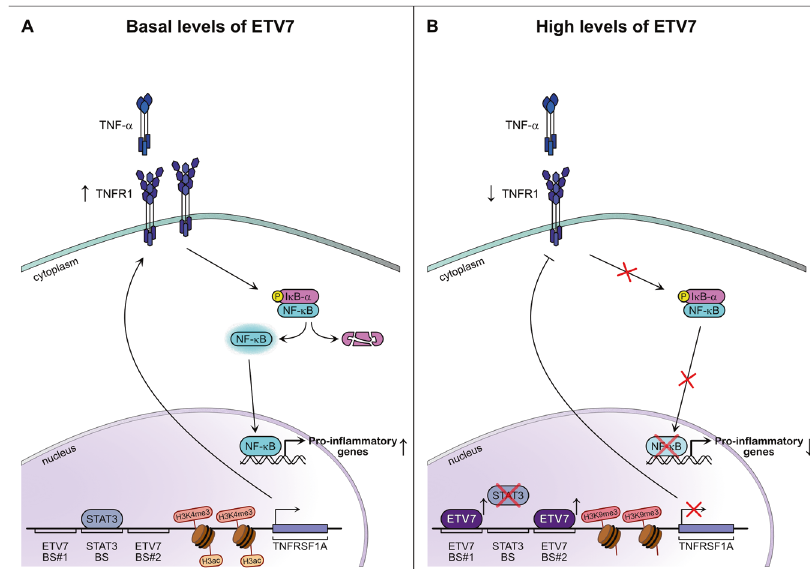
Fig. 7 ETV7 can compete with STAT3 in the regulation of the TNFRSF1A gene in fl uencing the NF- κ B regulatory pathway. A The canonical STAT3/TNF- α /NF- κ B regulatory pathway. STAT3 binds to its regulatory element in the fi rst intron of the TNFRSF1A gene and induces its expression by recruiting chromatin remodelers that result in an “ active ” state. Consequently, the TNF- α receptor 1 is produced. TNF- α molecules bind the TNFR1 receptor and activate the NF- κ B signaling pathway. B In the context where ETV7 expression is increased, ETV7 can displace STAT3 from its binding sites on the Intron 1 of TNFRSF1A and directly represses its expression by altering the deposition of histone marks. This ETV7-mediated repression leads to the reduced activation of NF- κ B signaling and, hence, reduces the expression of pro- in fl ammatory